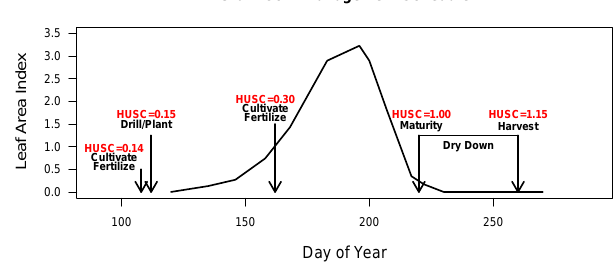
Fig. C1. Example EPIC grain corn management schedule for the North Carolina Coastal Plain. HUSC is the heat unit scheduling